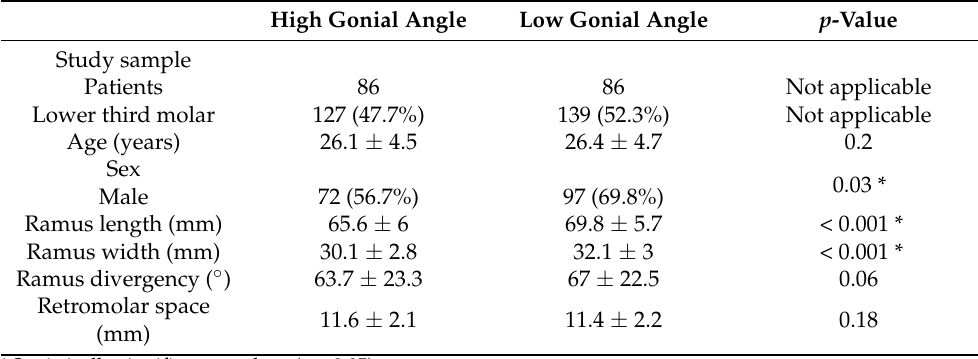
Table 2. Bivariate comparisons between the primary predictor variable (gonial angle) and the other variables.